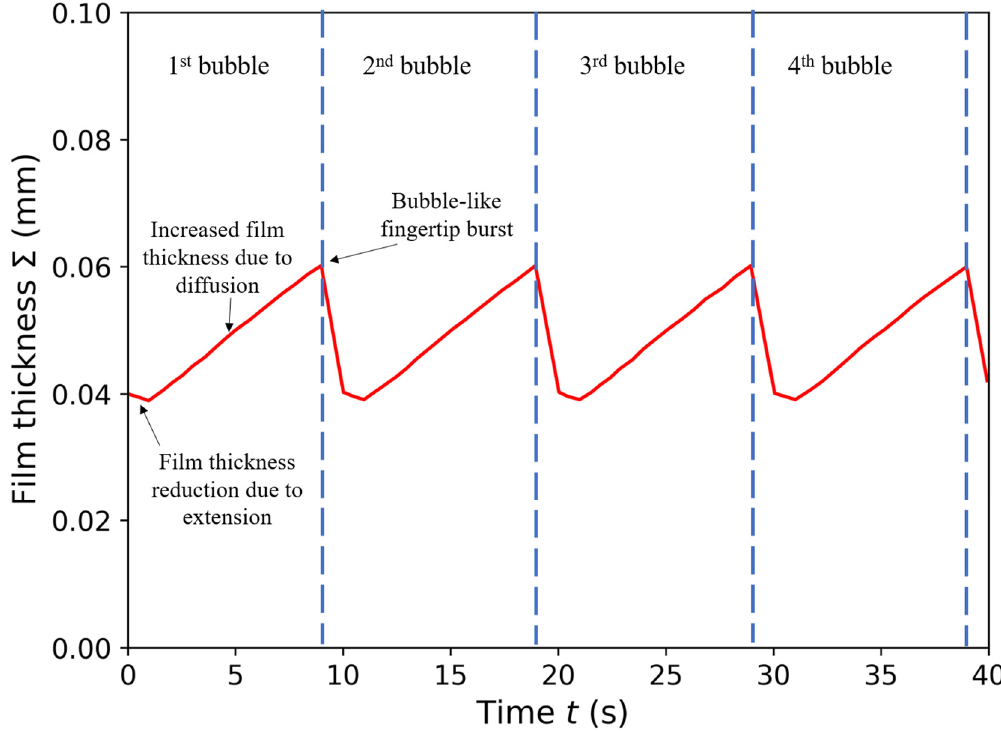
Figure 9. Sequential change in the interfacial gel film thickness based on Equation (12) considering periodic rupture at the fingertip. The parameters are set as follows: D = 9.3 × 10 − 11 m 2 /s, b = 0.4 mm, Q = 1.0 mL/h, r 0 = 0.4 mm, and C = 3.404 × 10 − 5 m√s . The film thickness changes from decreasing to monotonically increasing as a one-cycle bubble formation. Periodic rupture occurs approximately every 9 s.